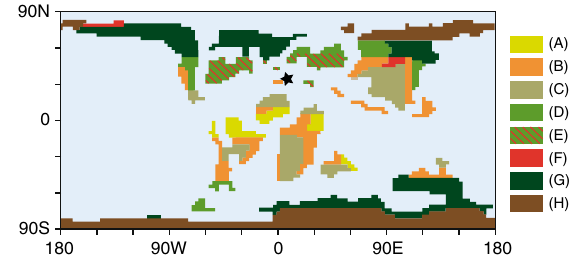
Fig. 1 Palaeogeographic map illustrating Cenomanian – Turonian biome distribution. Palaeo-map is modi fi ed after ref. 48 and includes the extent of the Normapolles palyno fl oral province 29 . Color code representing ( A ) tropical moist, open canopy mixed forest with shrub understory; ( B ) savanna-type dry low understory with sparse trees; ( C ) deciduous dry/ warm shrubland; ( D ) mid-latitude evergreen closed canopy conifer forest; ( E ) Normapolles province; ( F ) evergreen wet/cool shrubland; ( G ) high- latitude moist, open canopy forest with shrub understory; ( H ) boreal closed canopy conifer forest. Asterisk marks approximate location of the